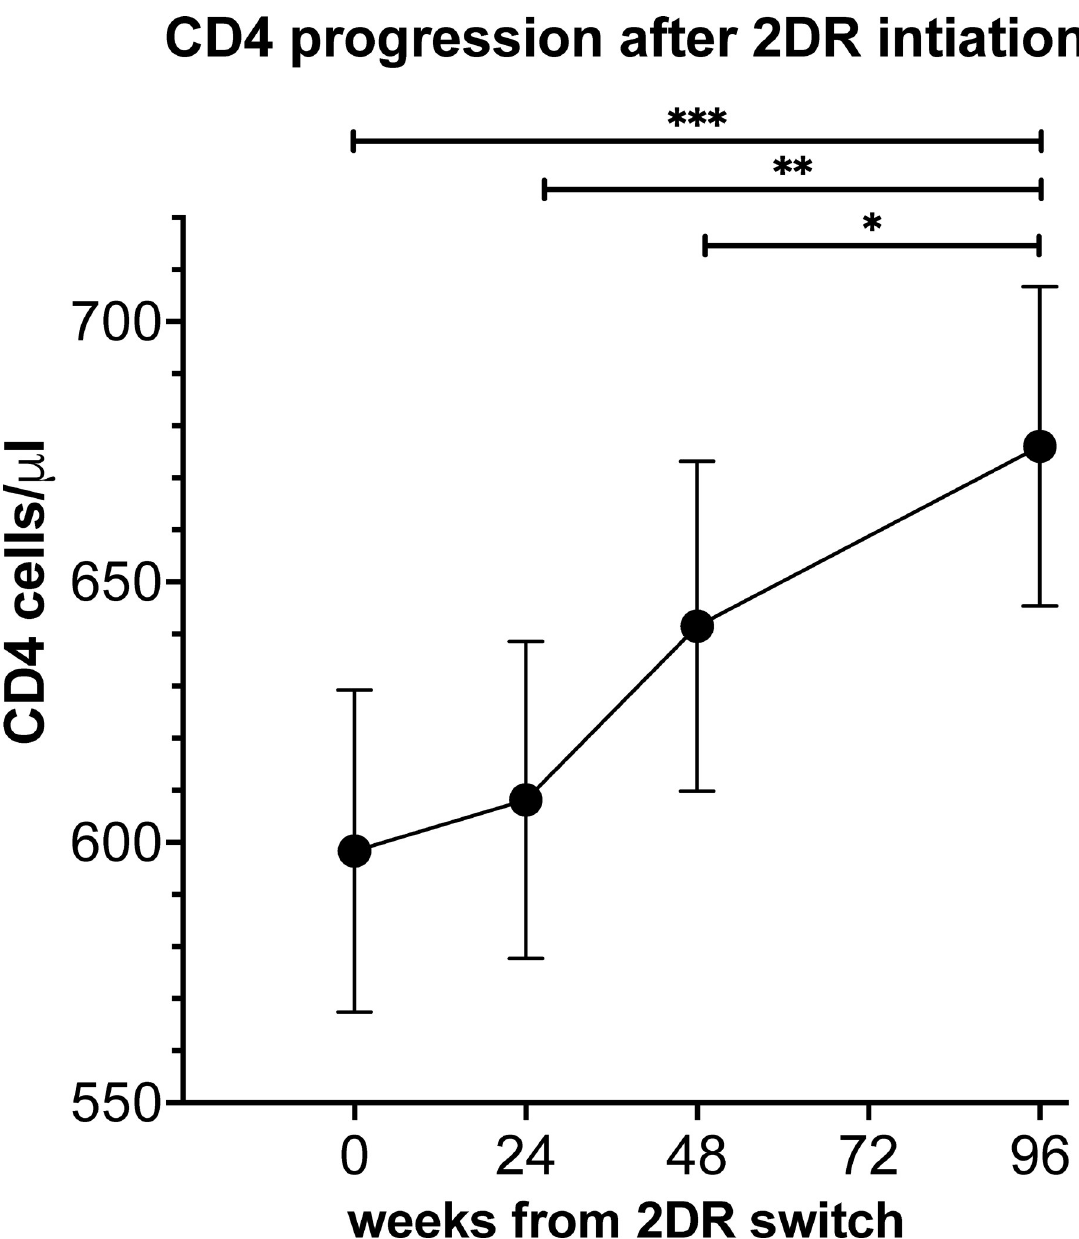
Fig 3. CD4 progression after switch to 2DR. 92 patients with consecutive CD4 measurements were included. Results are expressed ± SE. ��� p < 0.0001 �� p = 0.02 � p = 0.038. total cholesterol levels (p = 0.834) were documented following the switch. Analyzing LDL lev- els in 46 patients with available results at 2DR initiation, 24W, 48W and 96W, of whom 23.9% were pretreated with PI, and in 26.1% PI was one of the 2DR components, indicated a signifi- cantly decreased from 112.98 ± 30 mg/dl to 103.4 ± 29.8 mg/dl (p = 0.021). This effect also trended by comparing by paired T test of LDL at dual initiation and 96W of 79 patients (113.6 ± 32 mg/dl vs 106.99 ± 31.2 p = 0.067) but was not reproduced in 24W and 48W (p = 0.29 and P = 0.665 respectively).